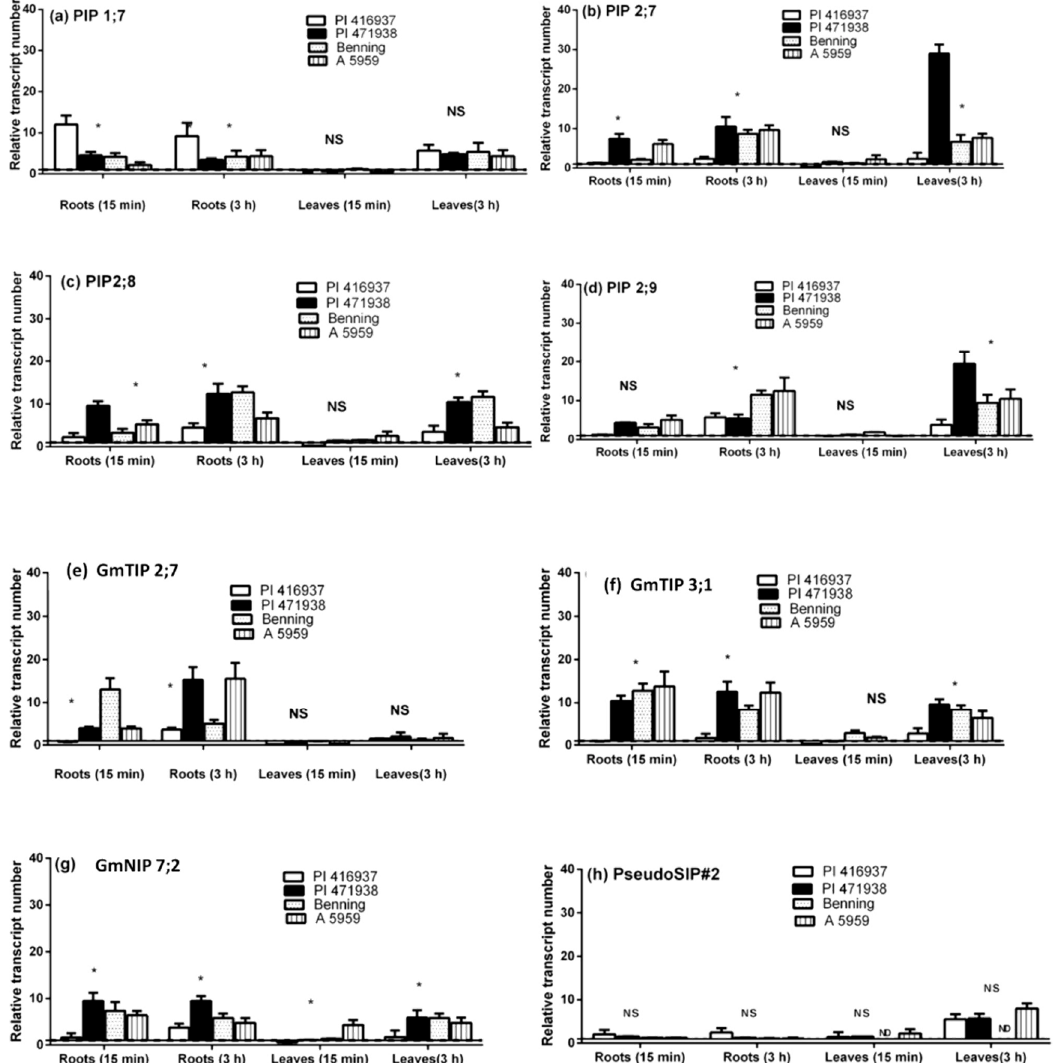
Figure 4. RNA abundance response relative to untreated tissues 15 min and 180 min after treatment with 200 μ M AQPs inhibitor [silver nitrate (AgNO3)] of eight AQPs: ( a ) PIP 1;7; ( b ) PIP 2;7; ( c ) PIP 2;8; ( d ) PIP 2;9; ( e ) GmTIP 2;7; ( f ) GmTIP 3;1; ( g ) GmNIP 7;2; and ( h ) PesudoSIP#2 in soybean roots and leaves [42]. Bars indicate transcript abundance ±S.E. Those noted with * are significantly different at P < 0.05, NS are non-significant and ND are not detectable.